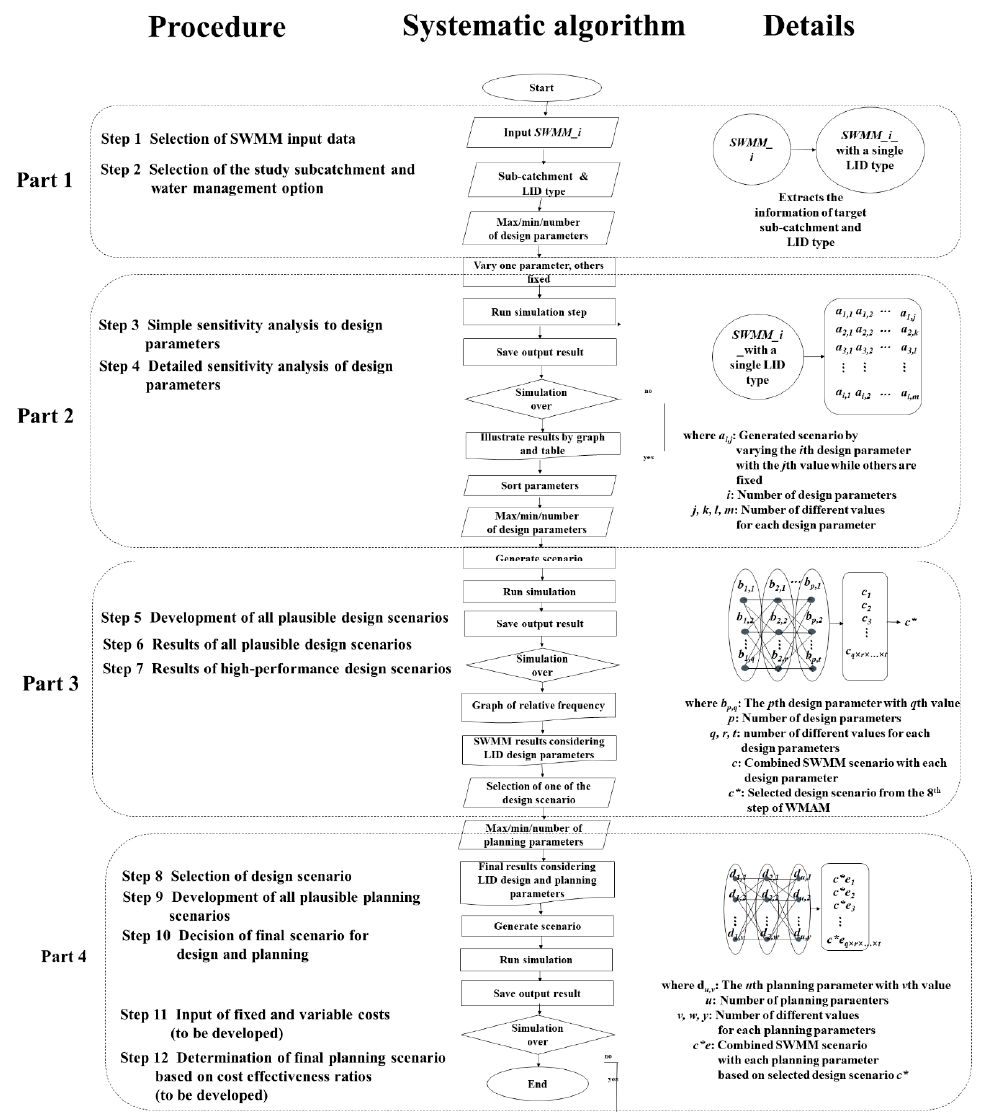
Figure 2. Detailed water-management analysis module (WMAM) procedure.